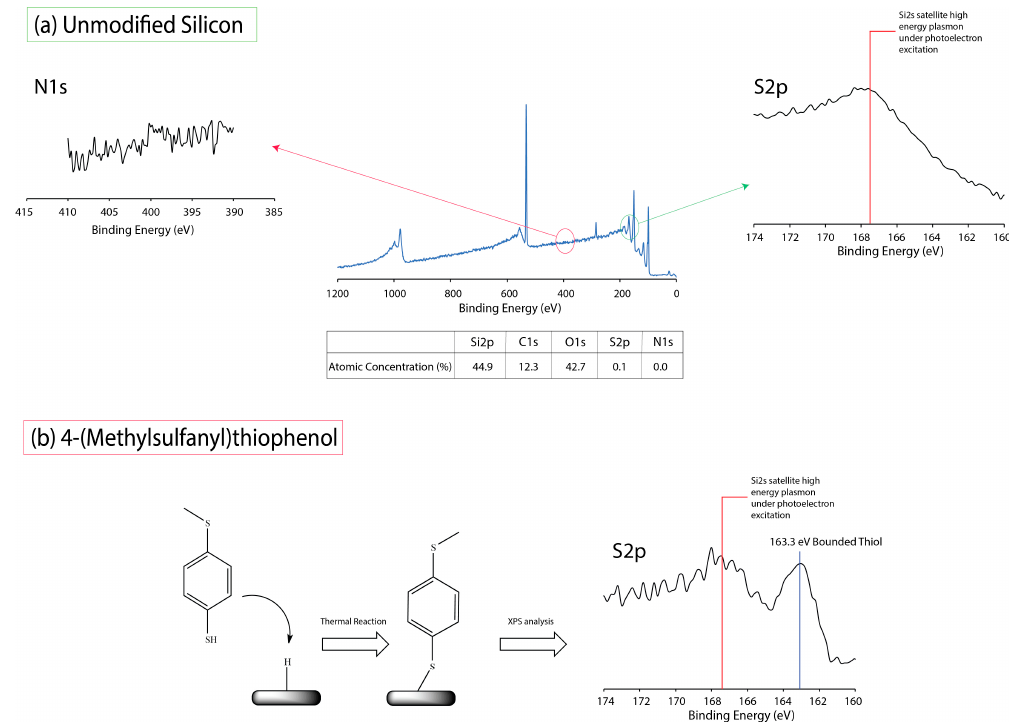
Figure 3. Survey spectrum, high-resolution XPS S2p and N1s spectra for ( a ) unmodified silicon (111) and ( b ) the deliberate grafting of 4-(methylsulfanyl)thiophenol for elucidating the S2p peak (163.3